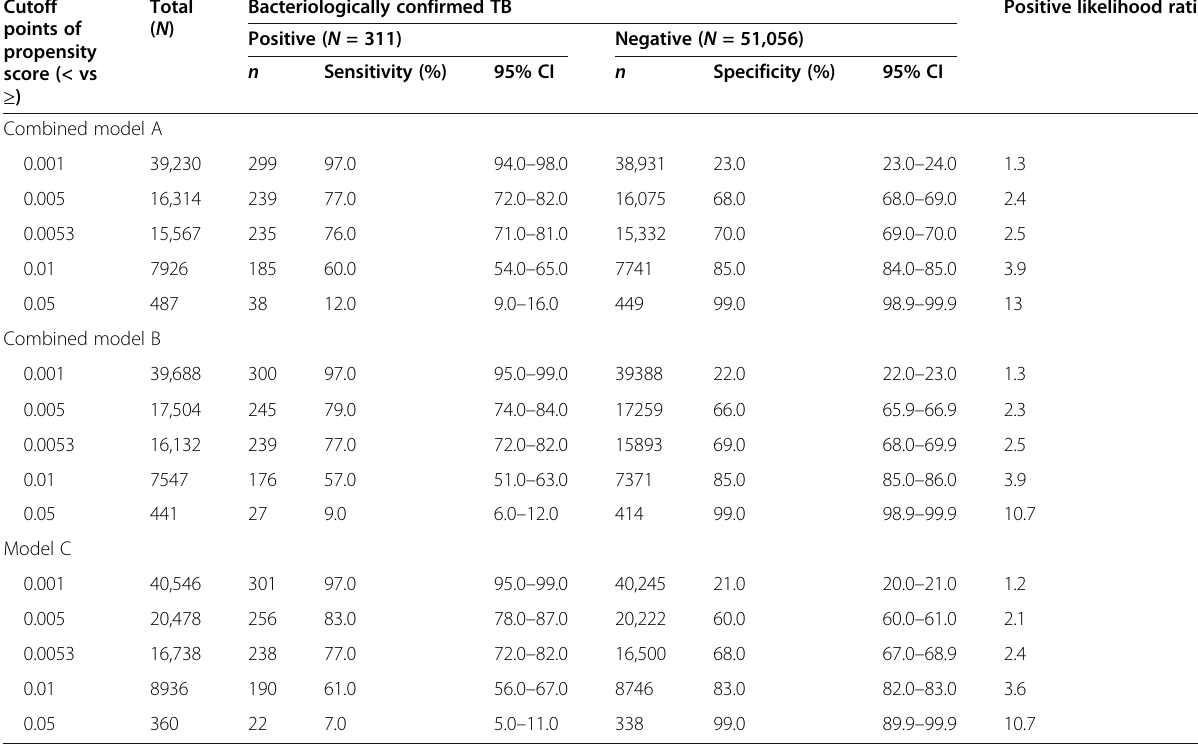
Table 7 Sensitivity, specificity, and positive likelihood ration to predict TB by different cutoff points of propensity score in various TB screening